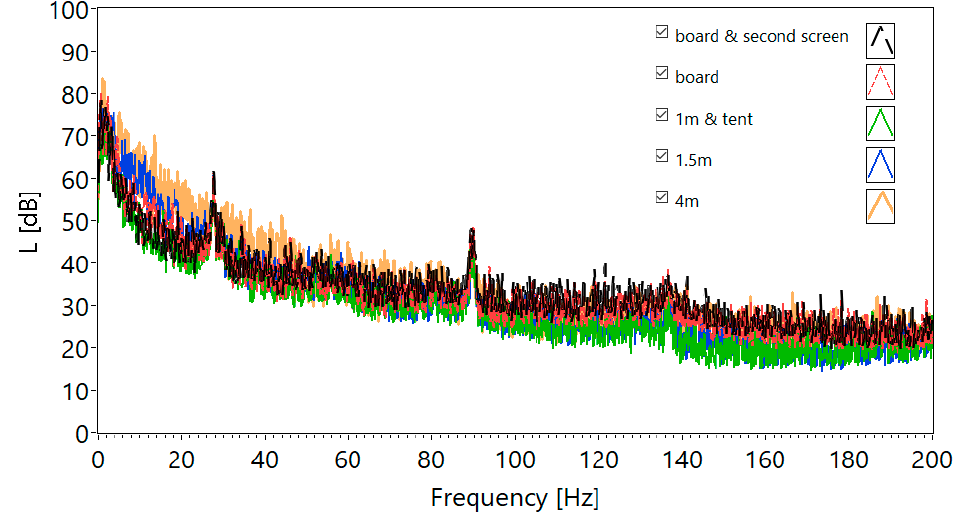
Figure 16. Wind turbine noise. FFT spectrum, average wind speed—2.1 m/s, max wind speed—4.5 m/s.